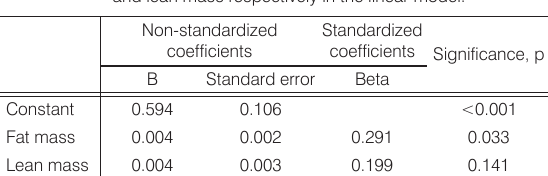
Table 3. Standardized and non-standardized regression coefficients describing the correlations of lumbar spine BMD and fat and lean mass respectively in the linear